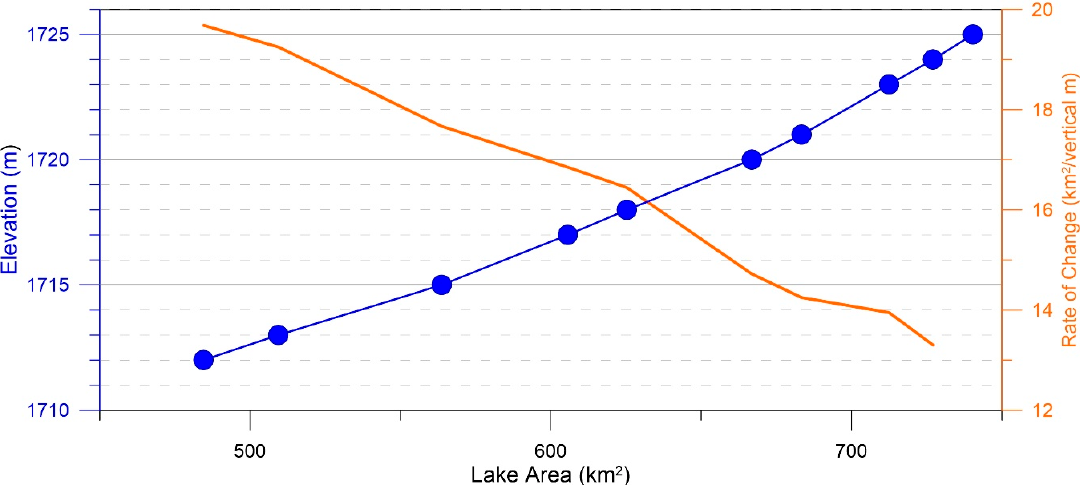
Figure 6. Reconstructed hypsometry of Lake Clover. The area of the lake ranged from 740 km 2 at the highstand, to 485 km 2 when the lowest shoreline was constructed (blue). The rate of change from one shoreline to the next increases at lower elevations (orange). Table 1. Samples from the Tobar Transect.